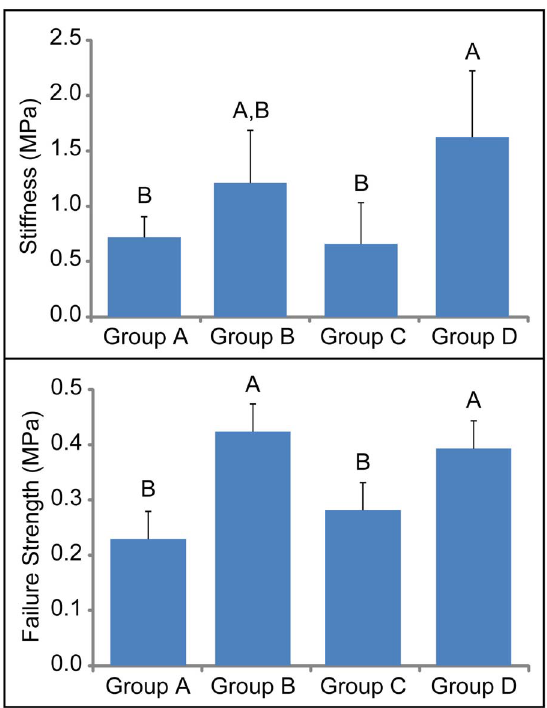
Figure 3. Tensile mechanical data of construct/explant inter- face. Significantly higher apparent stiffness (top) was seen when LOX was applied during t=15–35 d (Group D) than controls (Group A). Significantly higher apparent strength was obtained across the integration interface when engineered cartilage was treated with LOX before being press-fitted into the native cartilage (bottom). Bars with different letters are significantly different (p , 0.05).